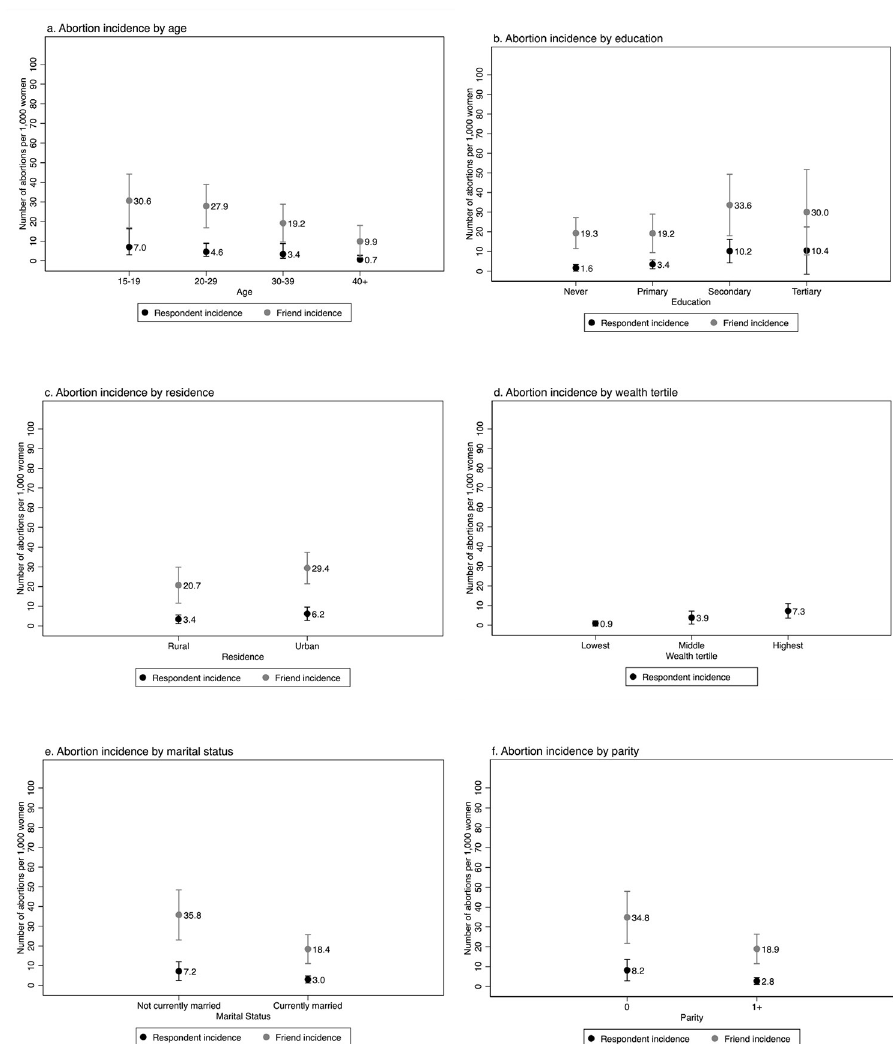
Fig 1. One-year annual incidence of induced abortion per 1,000 women aged 15–49 for respondents and friends in Burkina Faso by background characteristics,